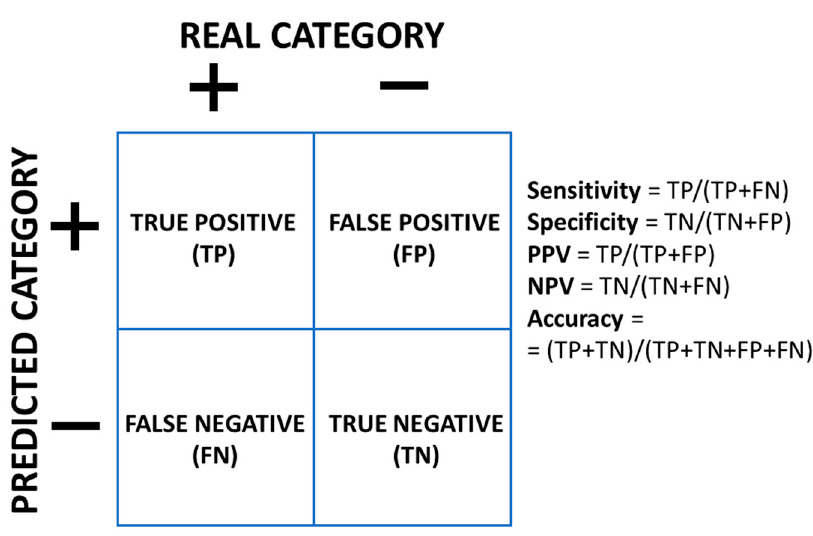
Figure 1. Measures of the performance of a binary classifier. Class labels are “ + ” and “ − “. Predicted category by the model is represented vs the real category, for all the possible situations.